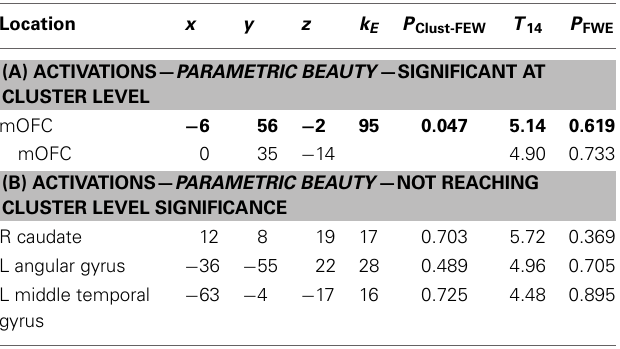
Table 2 | Activations for the categorical contrast beautiful > neutral